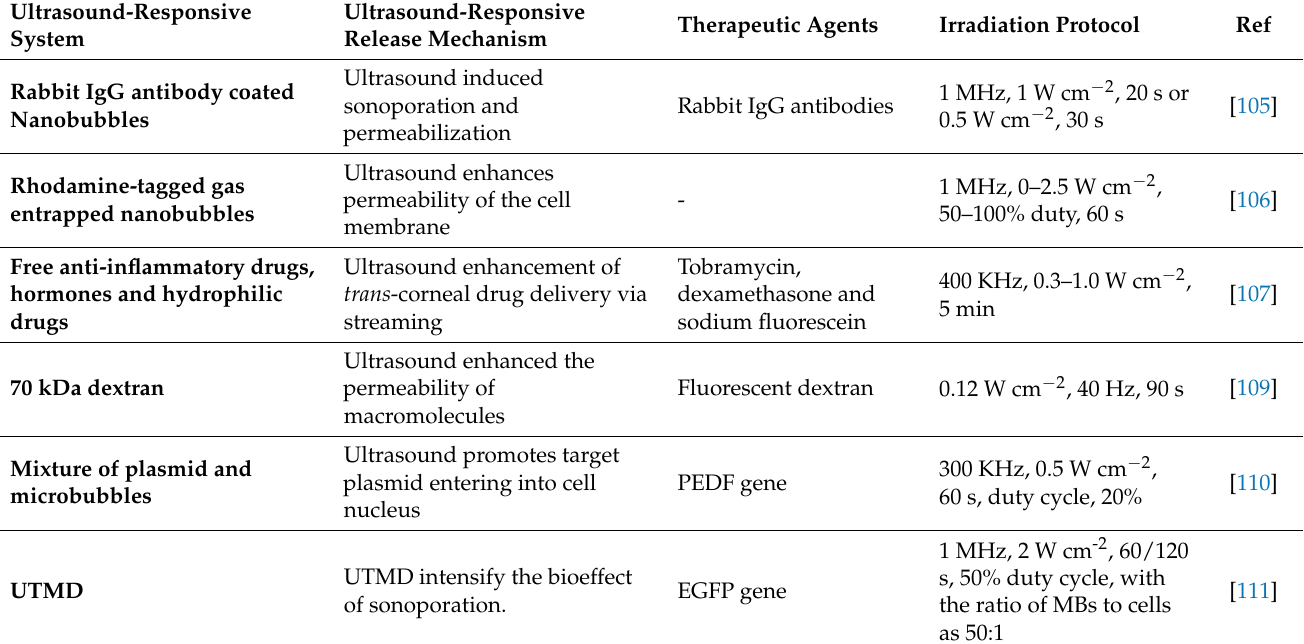
Table 2. Summary of ultrasonic energy responsive drug release systems in